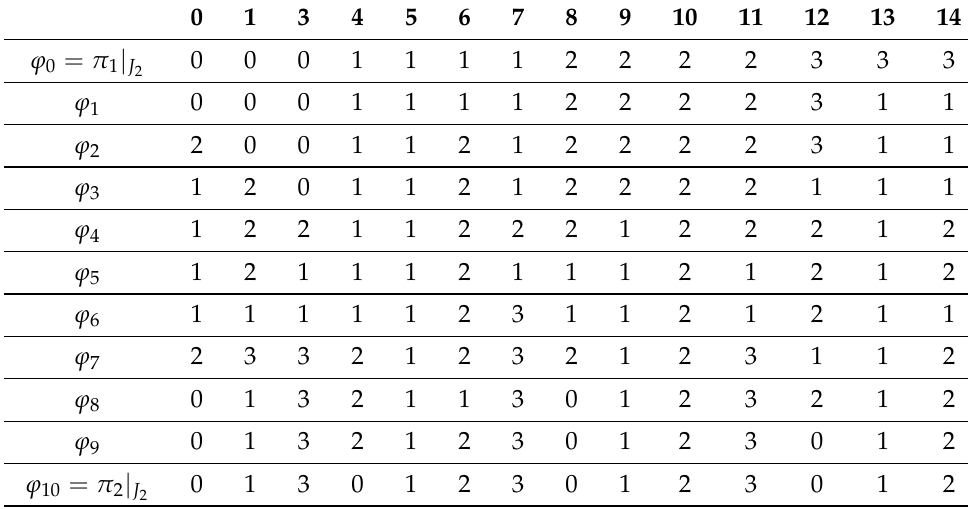
Table 5. Contiguity chain on J 2